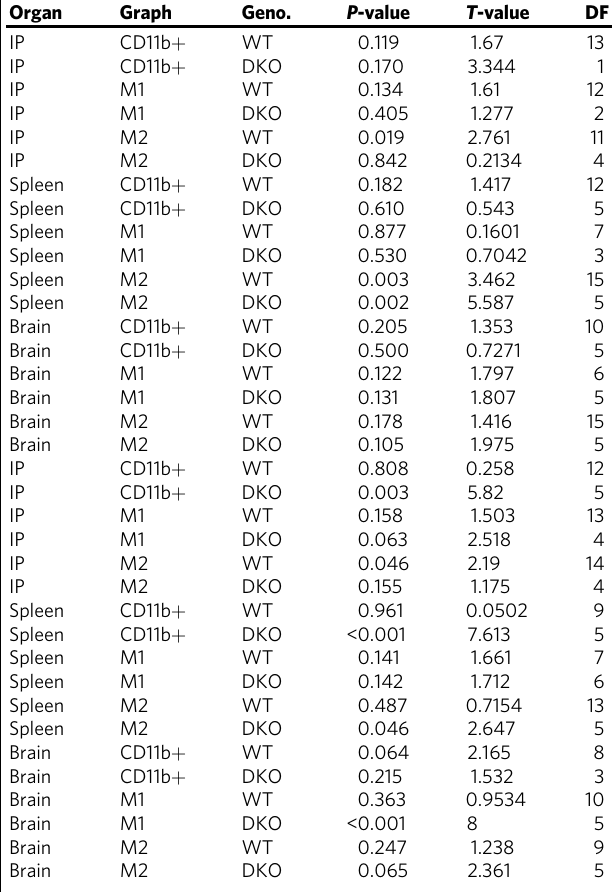
Table 2 Statistical details for Fig. 6c WT vs RIG-I/MDA5 DKO: counts percentages